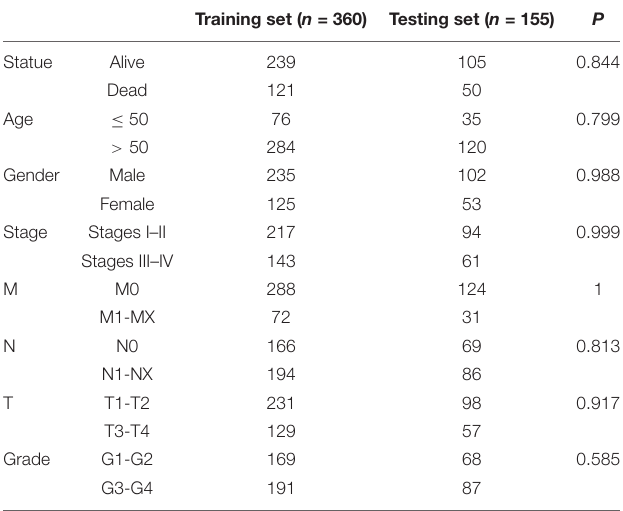
TABLE 1 | Clinicopathological characteristics of included KIRC patients from TCGA database. Training set ( n = 360) Testing set ( n = 155)